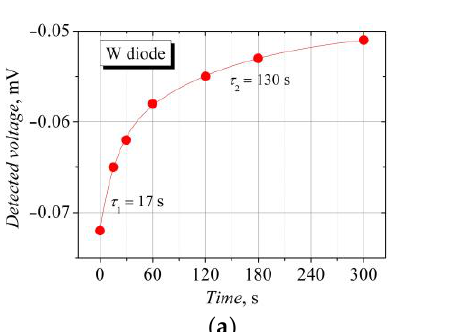
( b ) Figure 9. Temperature dependence of voltage sensitivity ( a ) and electrical resistance ( b ) of the bow-tie diodes on the base of a selectively doped InAlAs/InGaAs semiconductor structure with InAs inserts in the dark and under 14,400 lx illumination. Illumination also influences the dependence of the electrical resistance of the W-di- ode on temperature (see Figure 9b). The resistance of the illuminated diode depends line- arly on temperature, and it is almost constant at a temperature close to room temperature in the dark. At higher temperatures, the resistance of the “dark” diode begins to increase faster with temperature, and it approaches the resistance of the illuminated diode. The different temperature dependences can be explained as follows: the resistance of the illu- minated diode is related to the dependence of the charge carrier mobility on temperature, while the resistance of the “dark” diode is additionally influenced by the change in the charge carrier density caused by the temperature change. The dependence of the detected voltage on frequency can help better understand the origin of the voltage. These dependencies, in the dark and under illumination, are pre- sented in Figure 10. They are similar; however, this is most probably not due to the prop- erties of the W-diode itself but rather the features of the microwave signal transmitting tract, specifically the high-frequency probe station. The experimental frequency depend- ence of the voltage sensitivity of the W-diode in the dark can be compared with the theo- retical voltage sensitivity of the bow-tie diode with the semiconductor n-n + junction [44]: 0 2 2 (4) where P is the microwave power absorbed by the diode; P i denotes the incident micro- wave power; μ 0 is the low-field electron mobility; and N stands for the factor that depends on the frequency and electron energy, pulse and the Maxwell relaxation times [44]. The calculated frequency dependence of the voltage sensitivity of the W bow-tie diode with